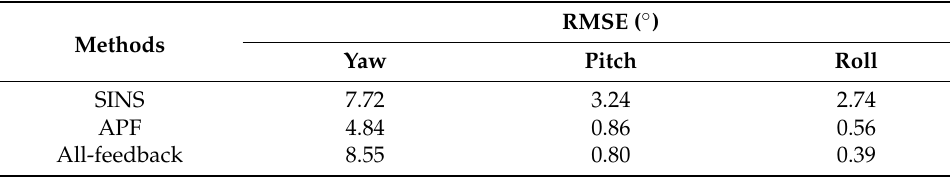
Table 6. Attitude estimation error statistics of dynamic simulation.